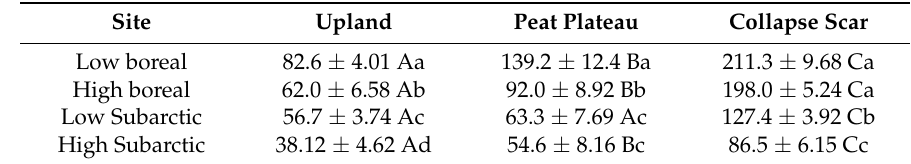
Table 6. Cumulative seasonal (1 June to 30 September 2009) net assimilation rate at different landform positions (in g · C · m − 2 · season − 1 ).